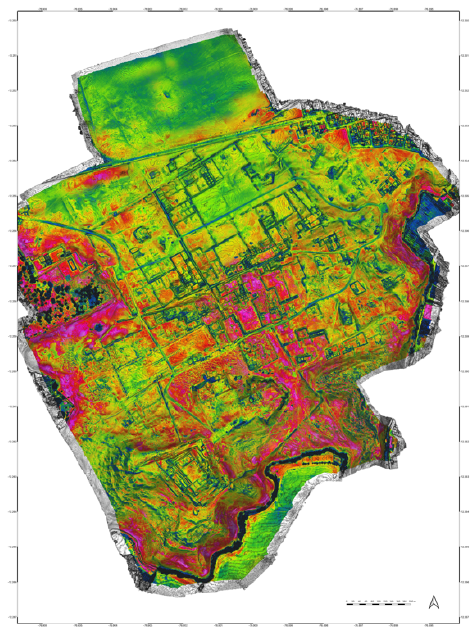
Figure 11 . Overlay of orthophoto and contour lines